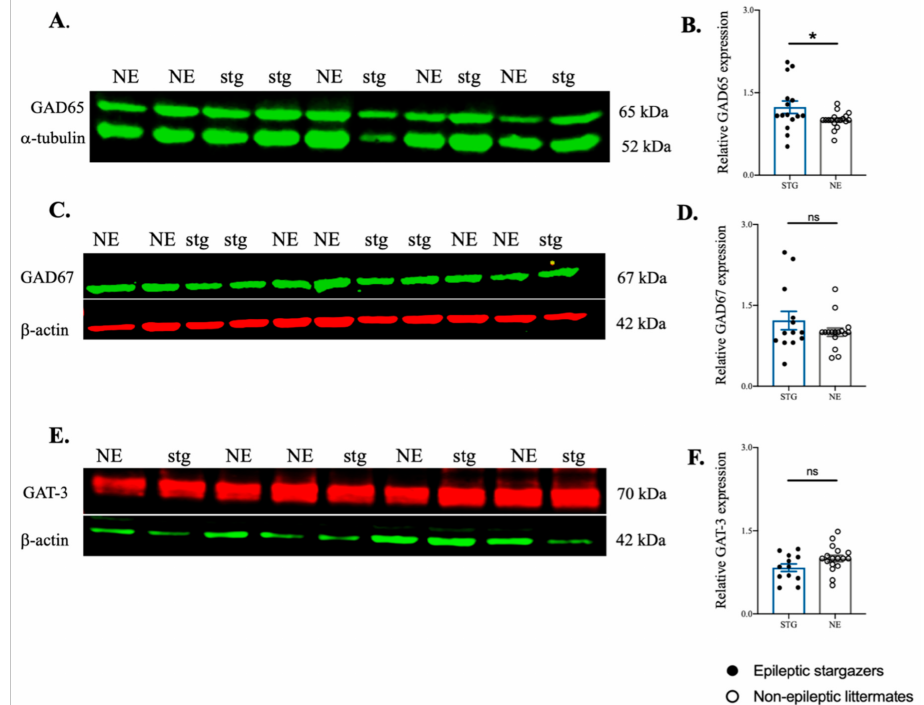
Figure 6. Western blot analysis of GAD65, GAD67, and GAT-3 in the SScortex of stargazers (stg) and non-epileptic littermates (NE). ( A , C , E ) Representative immunoblots showing the expression of GAD65, GAD67, and GAT-3 with the loading controls α -tubulin or β -actin, respectively. ( B , D , F ) Relative expression of GAD65, GAD67, and GAT-3 in the SScortex presented as bar graphs. All values represent mean ± SEM. Comparisons were performed using Mann–Whitney unpaired rank test. ns = non-significant, * = p <